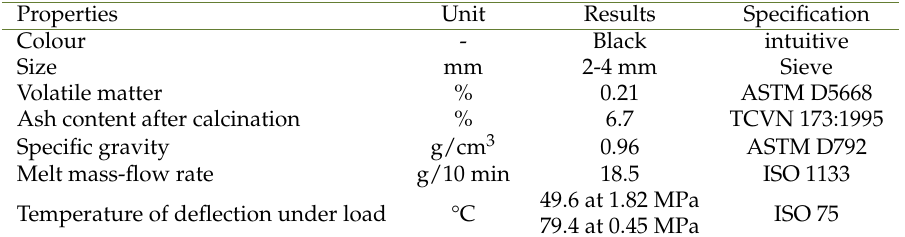
Table 2. Properties of